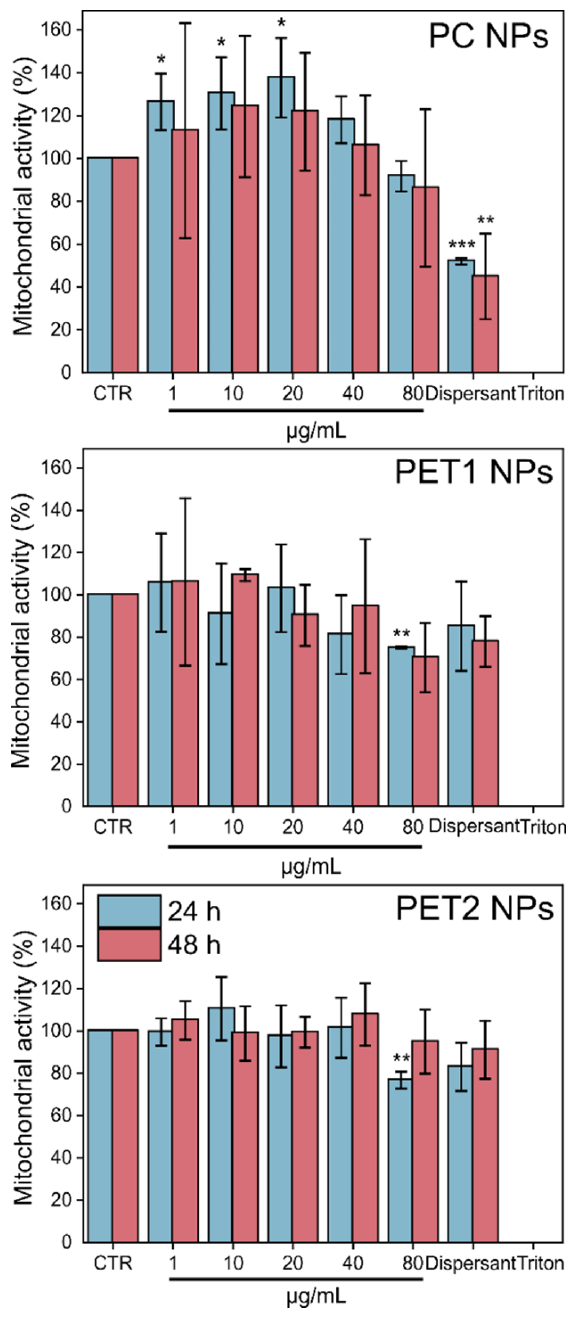
Figure 3. Mitochondrial activity of HePG2 cells after exposure to NPs at the concentrations of 1, 10, 20, 40, 80 µ g/mL for 24 or 48 h (MTT assay). Data are reported as average of three inde- pendent experiments (each run in technical triplicate) ± SD. p < 0.001, p < 0.01 and p < 0.05 are reported (***, ** and * respectively), calculated versus CTRL (one-way ANOVA). PET1 and PET2 resulted toxic only at the highest dose tested and only at the 24 h time point, which is in line with morphological observation (Figure S4). No significant toxicity was also observed in the case of the respective dispersants. No morphological changes were evident in the case of PET2 exposed cells at all doses tested (Figure